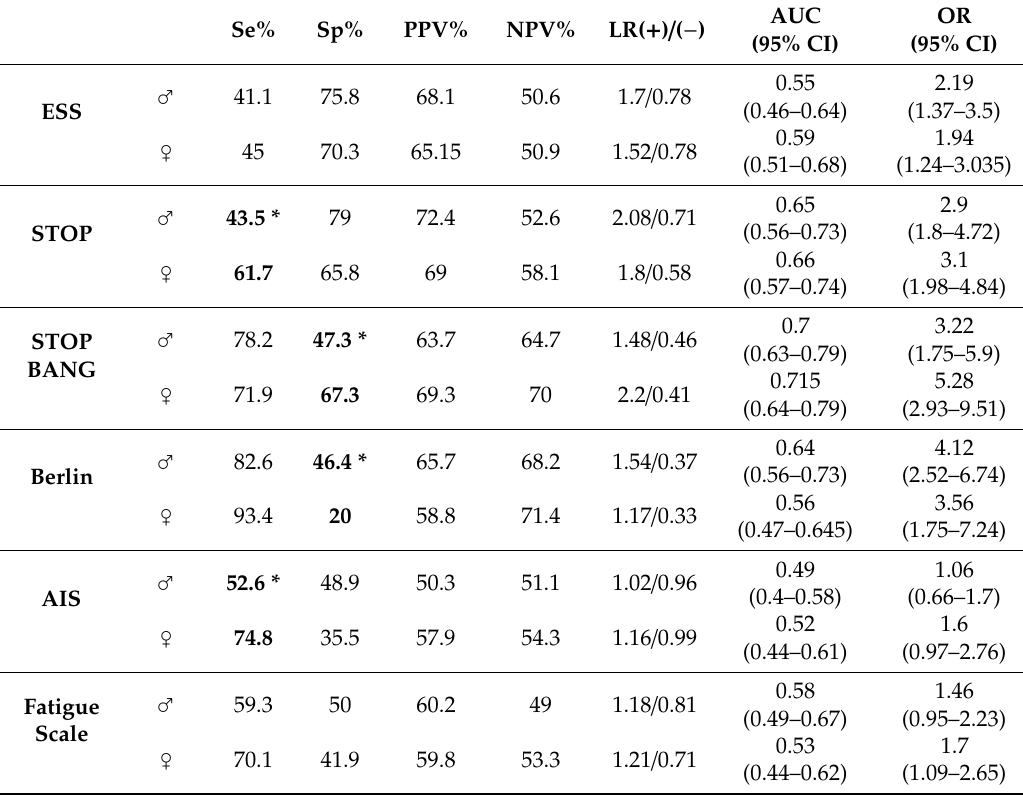
Table 4. Di ff erences between genders for the predictive values of di ff erent screening questionnaires (for REI > 15).